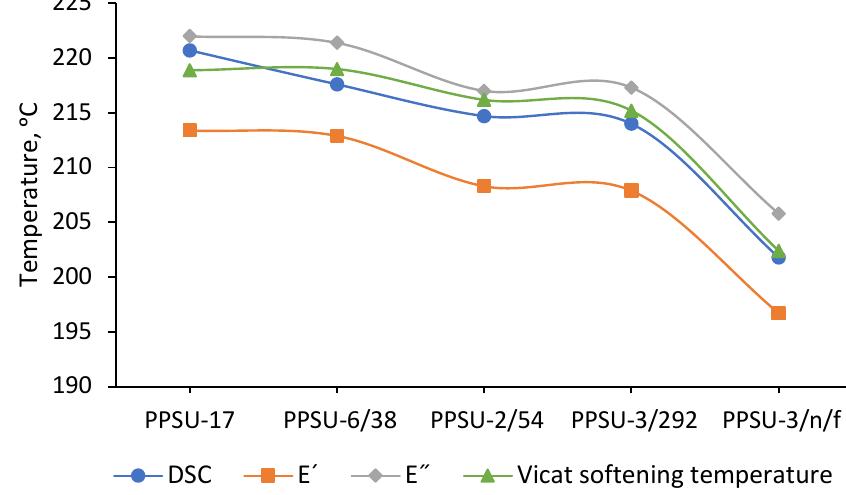
Figure 3. Tg and Vicat softening temperature curves of PPSU blends.